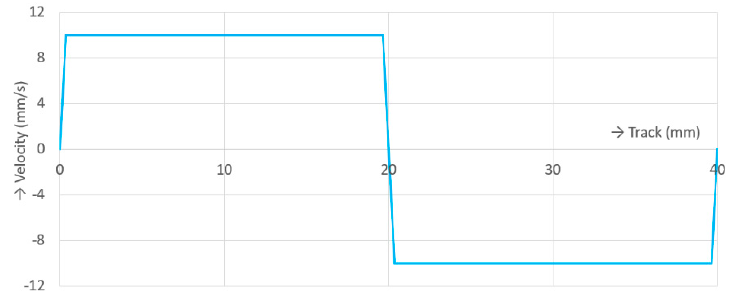
Figure 5. Sliding velocity trend.